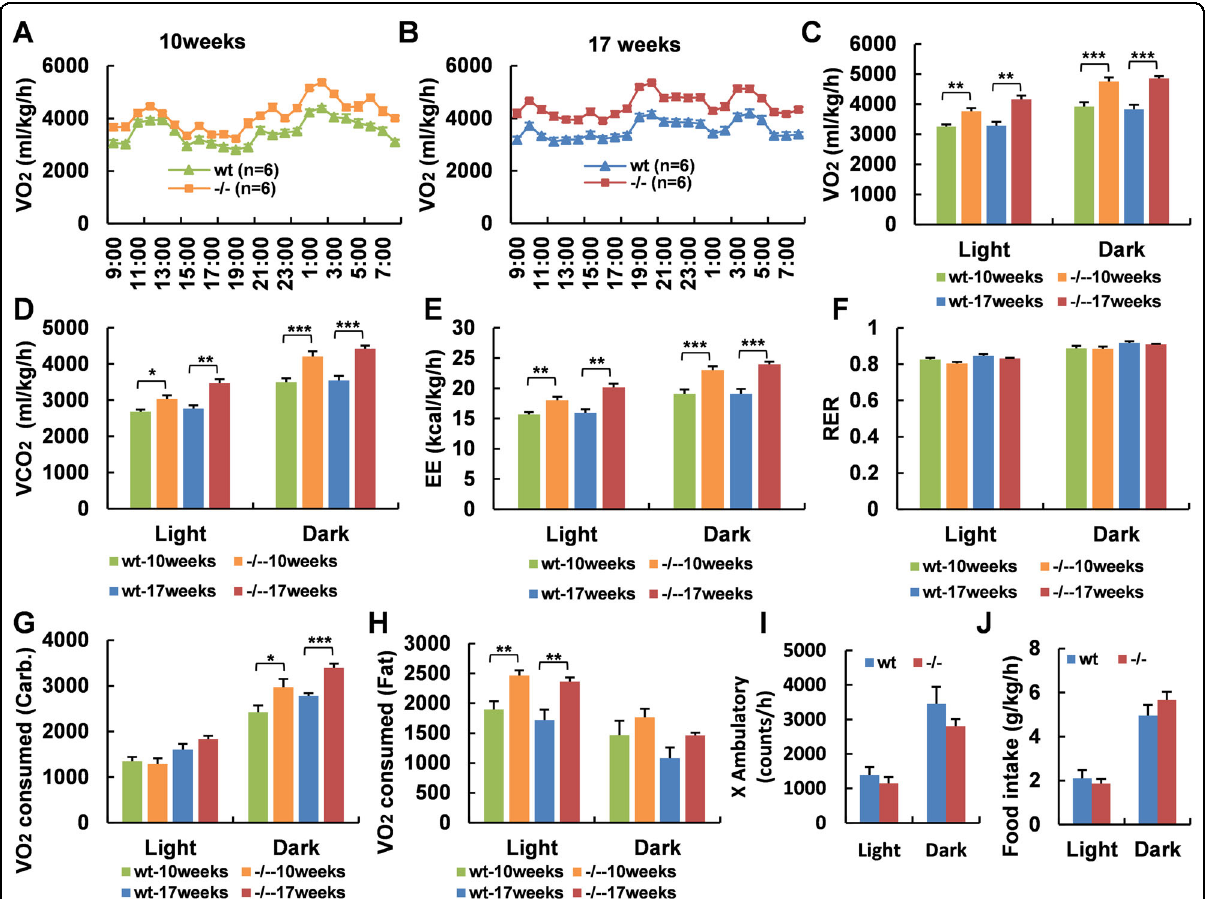
Fig. 2 Adgra1 de fi ciency induces increased energy expenditure in male mice. A – F At the age of 10 weeks and 17 weeks, the metabolic cage studies assess O 2 consumption in curve diagram ( A for 10 weeks, B for 17 weeks) and histogram ( C ), CO 2 production ( D ), energy expenditure ( E ), and RER ( F ) during light and dark of Adgra1 − / − male and control mice, n = 6/group. EE, energy expenditure. G , H O 2 consumption for carbonhydrate ( G ) and fat ( H ) during light and dark, n = 6/group. I Locomotor activities in both genotypes at the age of 17 weeks, n = 6/group. J Food intake in both genotypes at the age of 17 weeks, n = 6/group. * p < 0.05, ** p < 0.01, *** p < 0.001 vs. controls. Data represent mean ±